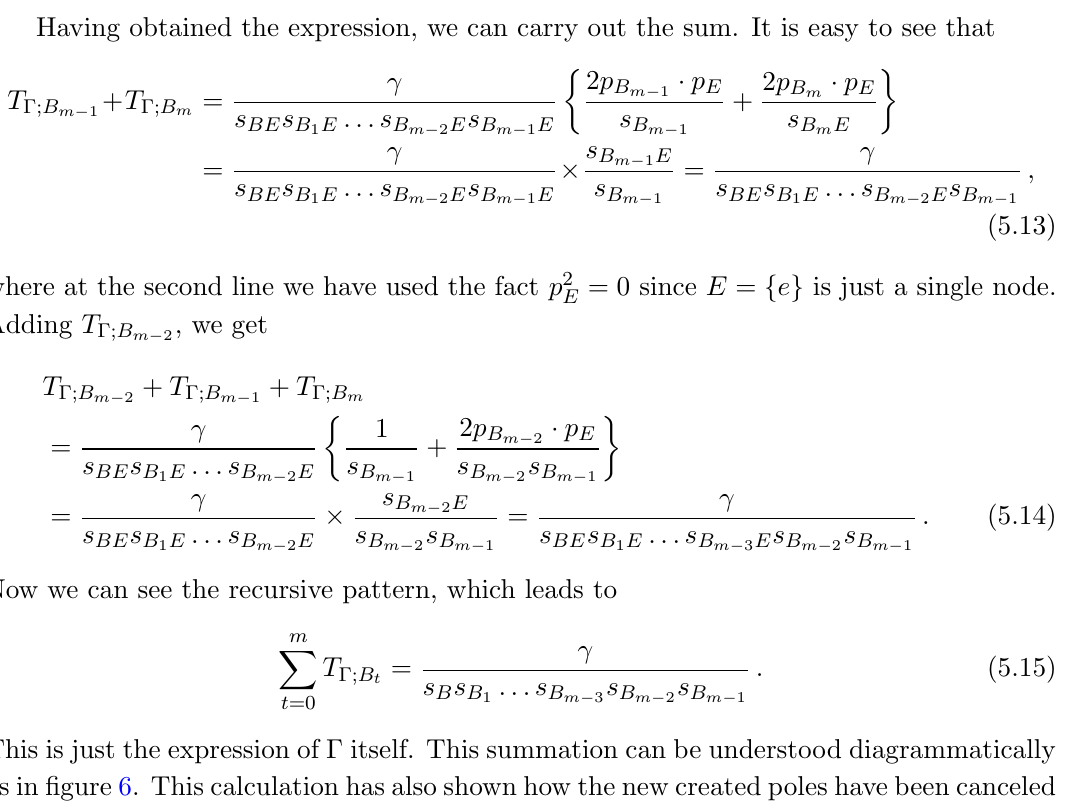
Figure 5. The Feynmann diagram (cid:0) of the sequence B m e attaches to this